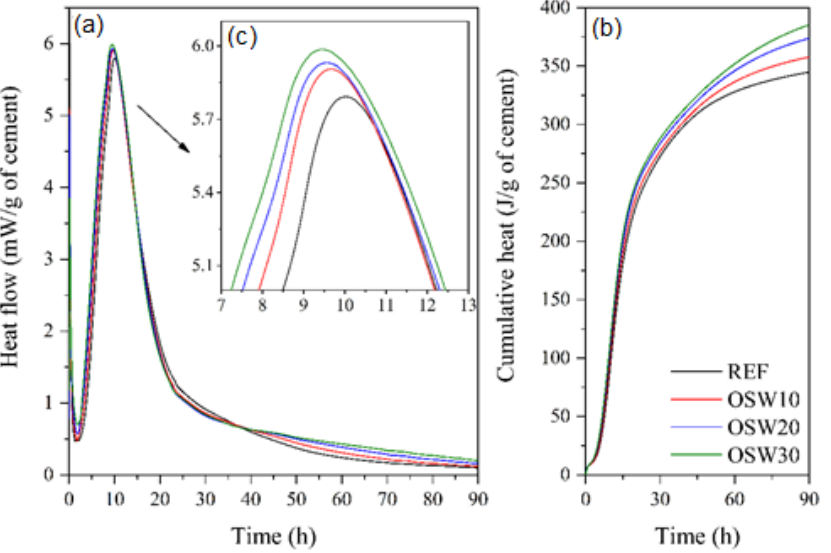
Figure 5. Hydration kinetics. ( a ) rate of heat evolution, ( b ) cumulative heat curves of the pastes, and ( c ) amplification of the main heat